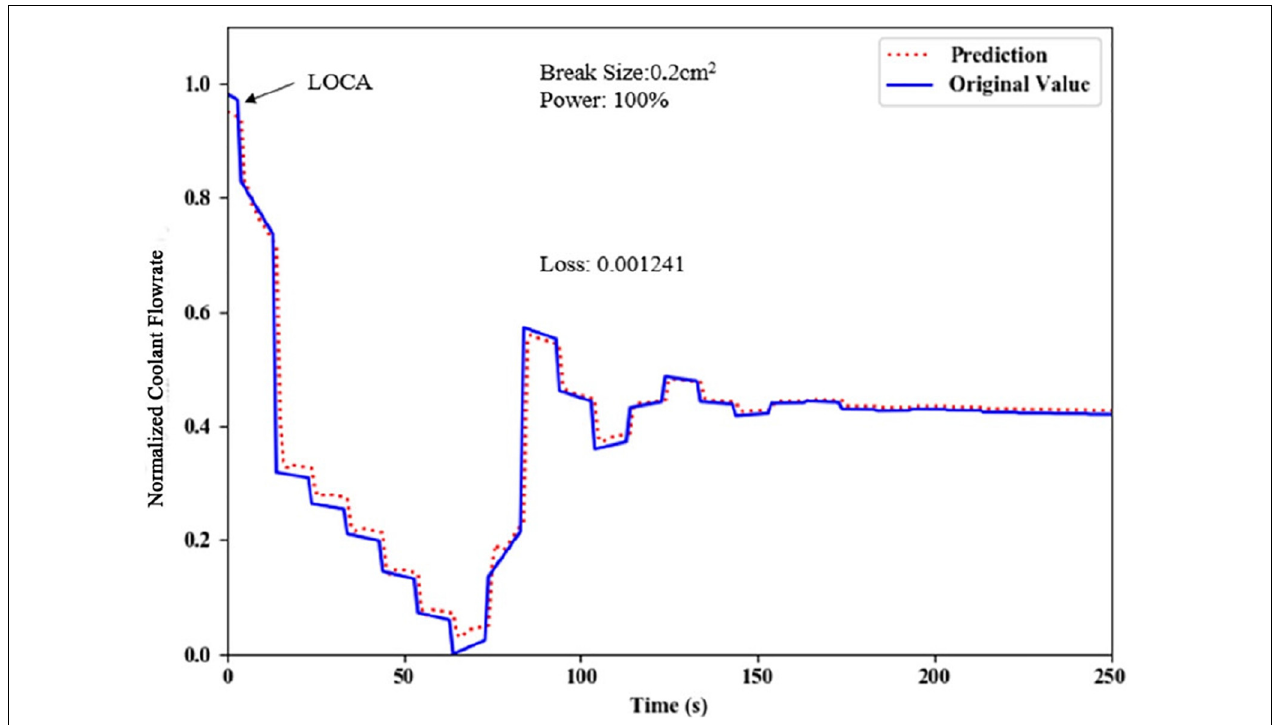
FIGURE 4 | Functionality verification of the prediction model.